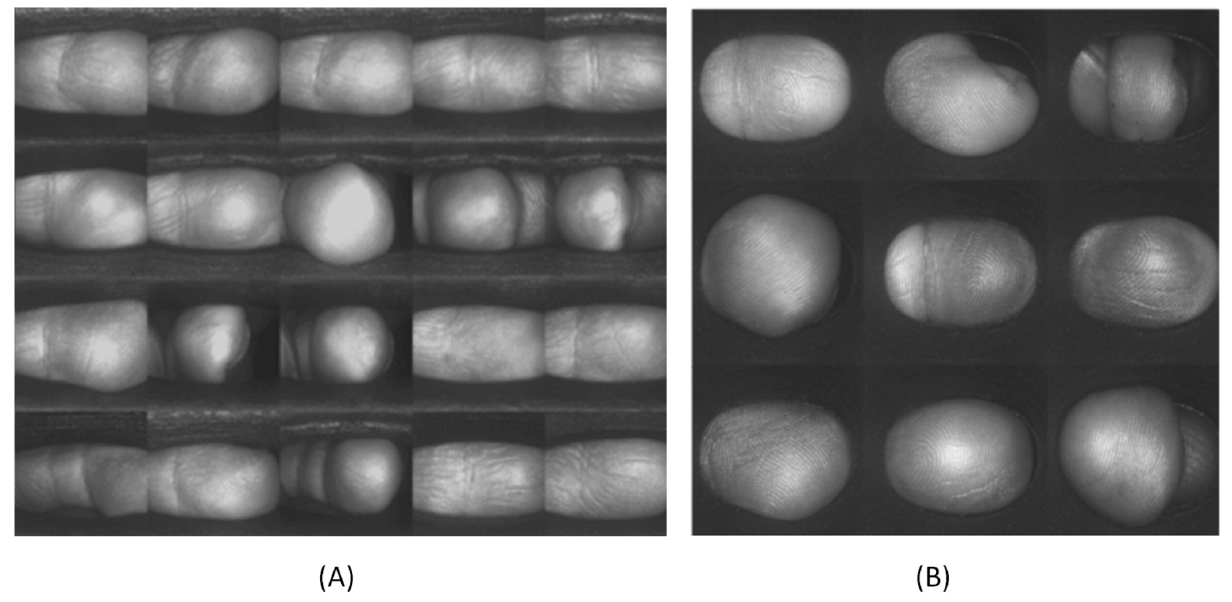
Figure 13. Examples of failure modes during finger placement. (a) Images collected with a roller top, and (b) images collected with a fixed